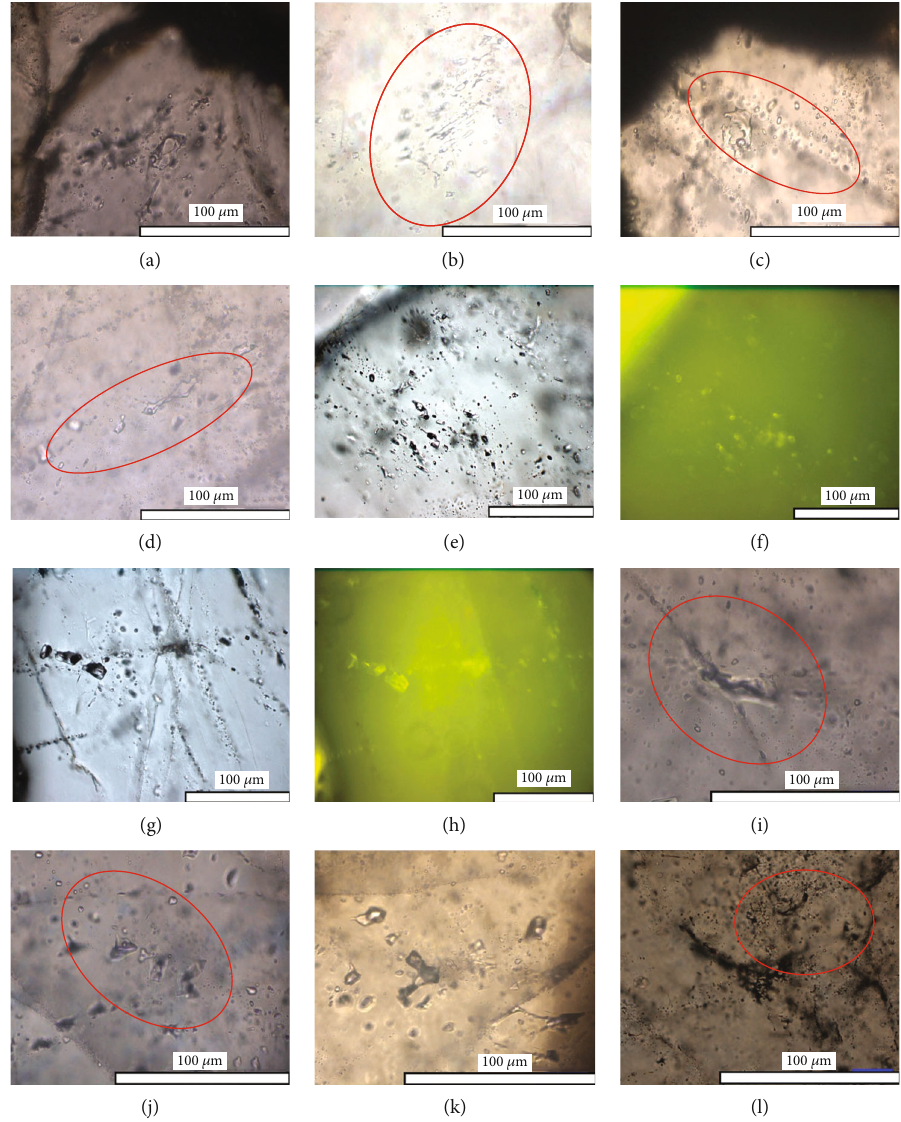
Figure 6: Microscopic characteristics of fl uid inclusions in the sandstone reservoir of the study area. (a) Gas-liquid two-phase inclusions in dissolution pores, He 3 well, Shan 1 section, 4146.16 m; (b) oriented gas-liquid two-phase inclusions in fi ssures in early stage, Lian 1 well, Shan 1 section, 3467.72m; (c) gas-liquid two-phase inclusions in dissolution pores, Lian 1 well, Shan 1 section, 3424.26m; (d) oriented gas-liquid two-phase inclusions in fi ssures in early stage, Qingshen 2 well, Shan 1 section, 4732.6m; (e) dark-colored hydrocarbon gas-liquid two-phase inclusions in the dissolution pores, He 3 well, Shan 1 section, 4146.62 m; (f) same view fi eld of (e) under the fl uorescence microscope; (g) dark hydrocarbon gas-liquid two-phase inclusions in early fi ssures, Lian 1 well, Shan 1 section, 3424.26 m; (h) same view fi eld of G under the fl uorescence microscope; (i) gas-liquid two-phase inclusions along late fi ssues, He 3 well, He 8 section, 4081.68m; (j) gas-liquid two-phase inclusions with beaded fractures and directional distribution, Qingshen 2 well, Shan 1 section, 4722.8 m; (k) late dark gas-rich inclusions, Lian 1 well, Shan 1 section, 3424.26m; (l) gas-rich inclusions with fracture distribution in late stage, Qingshen 2 well,